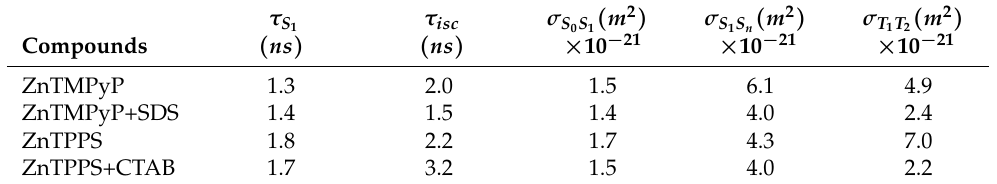
Table 1. Photophysical parameters of ZnTMPyP and ZnTPPS in aqueous solutions and their por- phyrin J-aggregates with micelles of SDS and CTAB at λ = 532 nm [50]. γ c = 1/ τ isc , Γ = 1/ τ . ( m 2 ) σ S ( m 2 ) σ T ( m 2 ) τ S τ isc σ S 1 T 2 1 0 S 1 1 S n Compounds ( ns ) ( ns ) × 10 − 21 × 10 − 21 × 10 − 21 ZnTMPyP 1.3 2.0